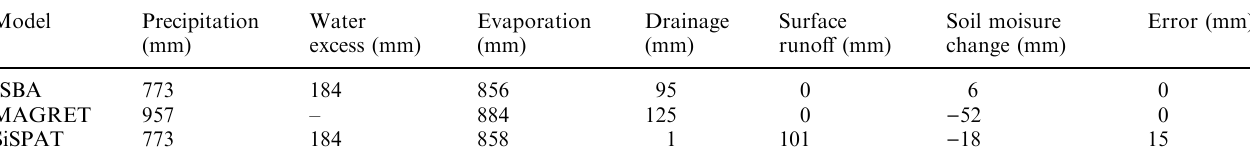
Table 2. The MUREX 1995 water budget as calculated by ISBA, MAGRET, and SiSPAT